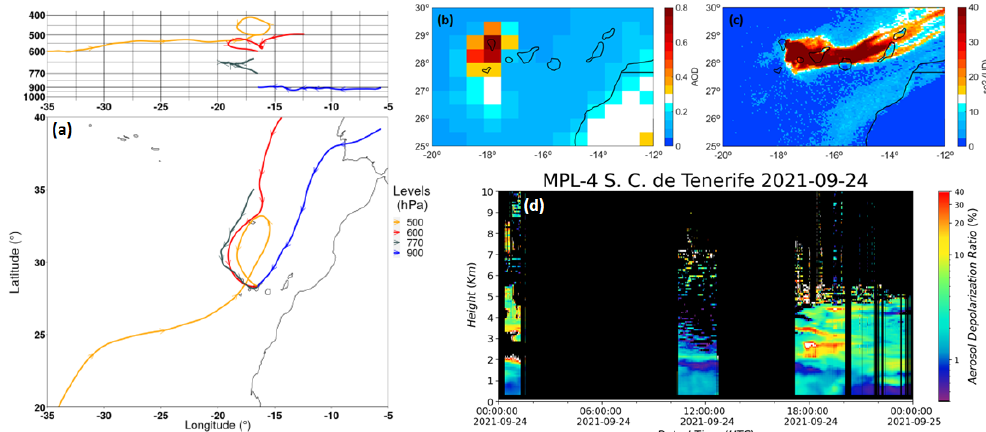
Figure 2. ( a ) Backward trajectories (72 h), ending point at the IZO at 12:00 UTC from FLEXTRA using ERA5 reanalysis at four pressure levels (900 (blue line), 770 (black line), 600 (red line), and 500 (orange line) hPa). ( b ) Daily average MERRA-2 AOD at 550 nm on 24 September 2021. ( c ) Satellite SO 2 total columns from Copernicus Sentinel-5P TROPOMI over the Canary Islands on 24 September 2021. ( d ) Aerosol depolarisation ratio ( δ aer ) determined from the MPL at 532 nm at the